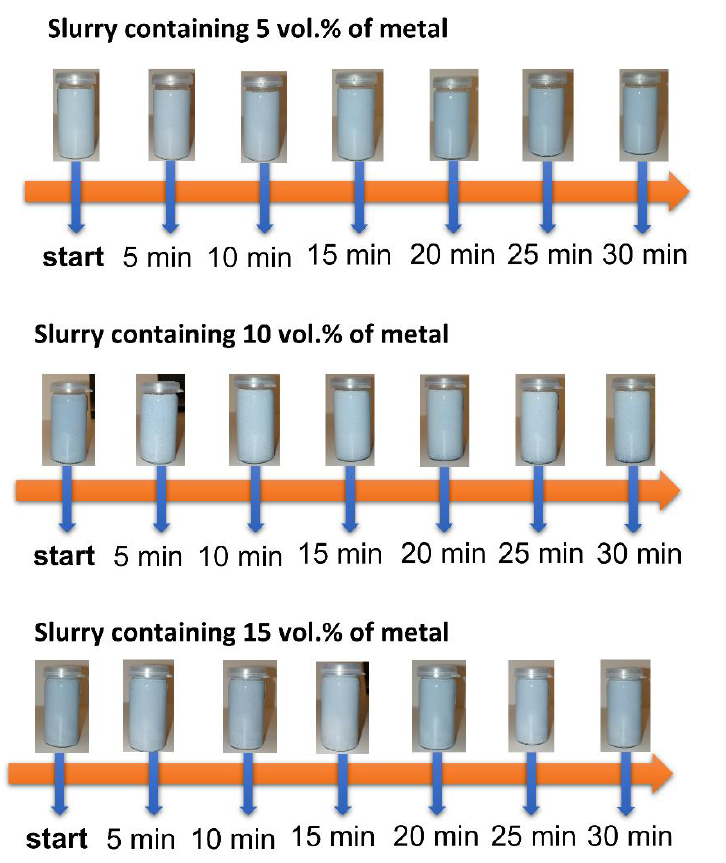
Figure 4. Macroscopic observations of slippery masses over time.